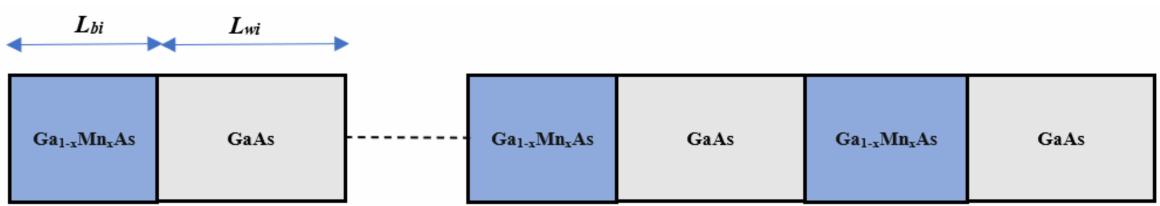
Figure 2. GaAs/Ga 1 − x Mn x As/GaAs symmetric structure, ( L bi = 1.5 nm, L wi = 2.5